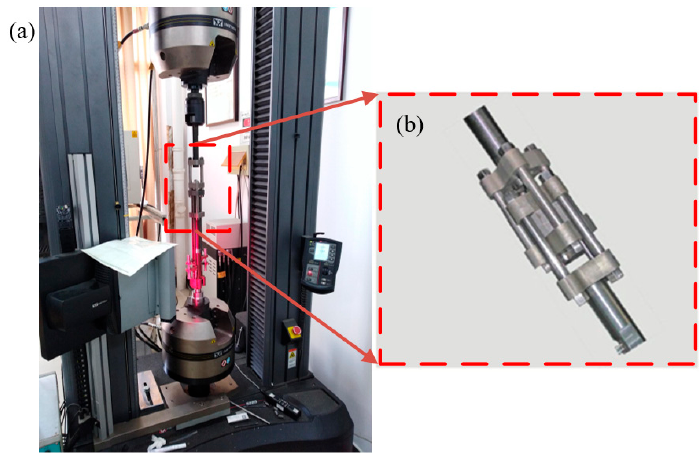
Figure 1. Experimental equipment for the quasi-static tests ( a ) Instron 5985 material universal testing machine and ( b ) fixture device.